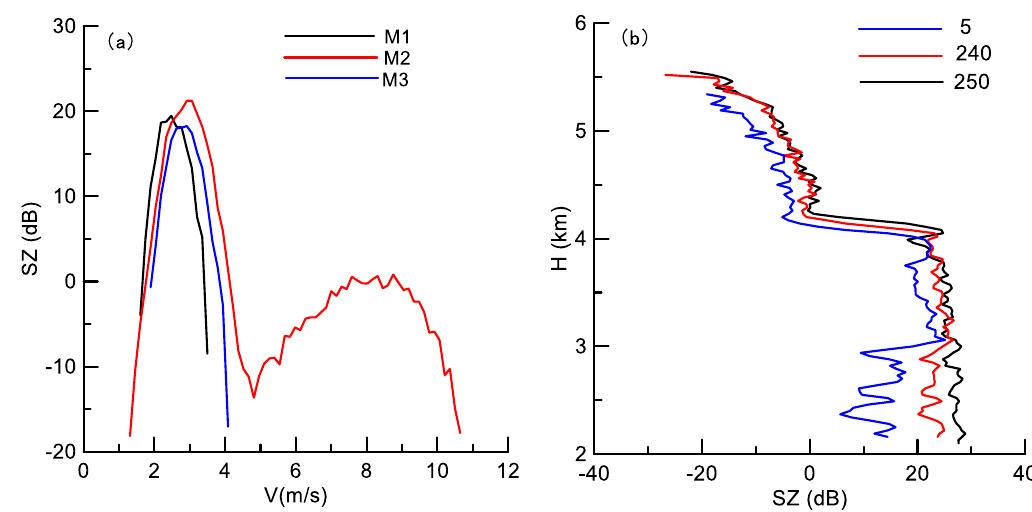
Figure 6. ( a ) SZ1, SZ2, and SZ3 for solid hydrometeors at 4.5 km, and ( b ) vertical profiles of SZ2 points at 5, 240, and 250 fast Fourier transform (FFT) points, produced by the liquid hydrometeor. The Doppler velocities for the three FFT points were 9.79, 8.156, and 8.88 m · s − 1 , respectively, which exceeded the fall velocity of the solid hydrometeor.